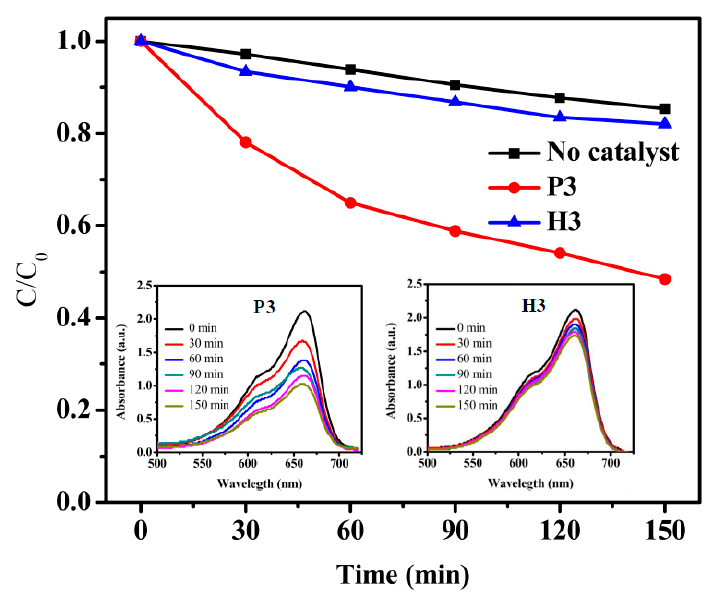
Figure 8. Results of the photocatalytic degradation of MB under UV irradiation by P3 and H3.